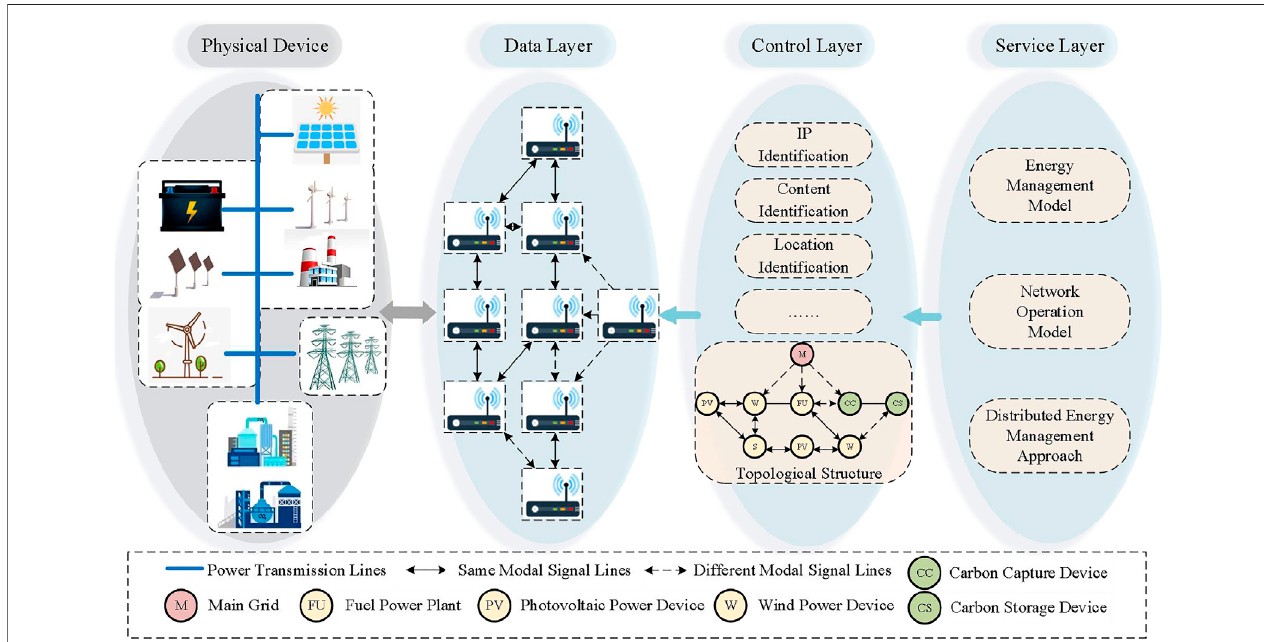
FIGURE 2 | The polymorphic network architecture of low-carbon port